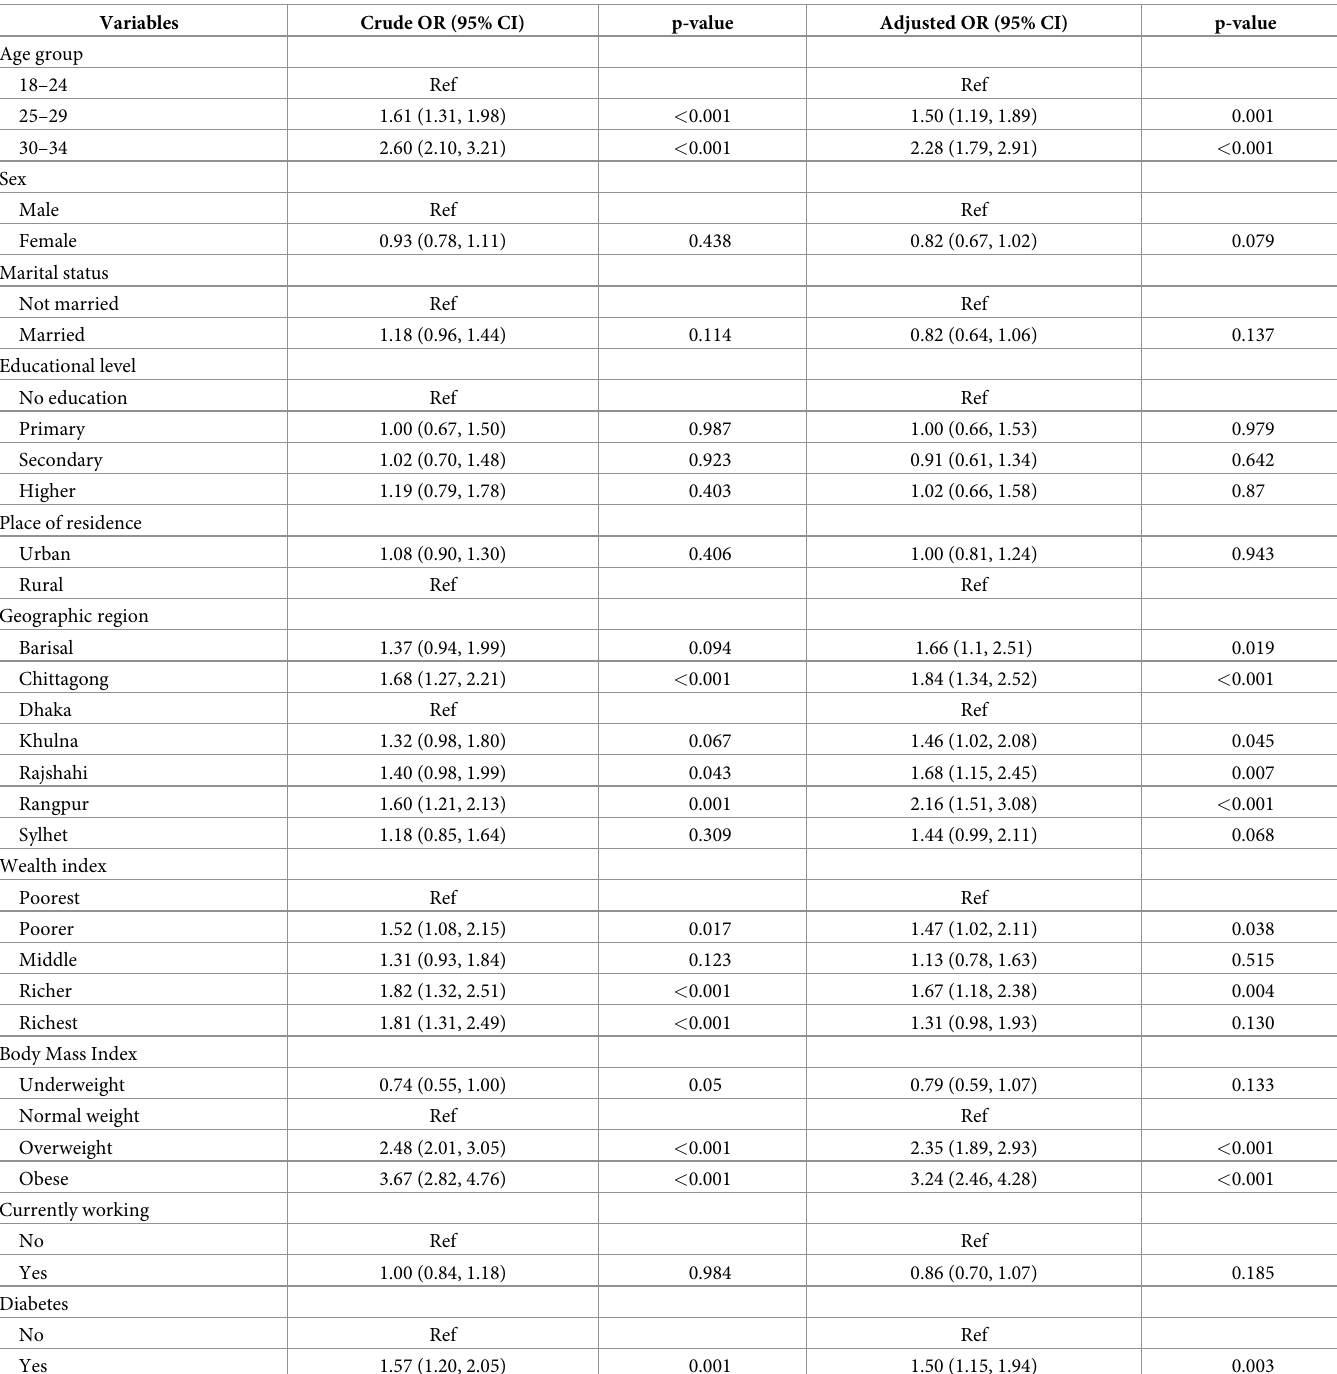
Table 3. Unadjusted and adjusted odds ratios of potential factors associated with hypertension among adults age 34 and younger in Bangladesh, BDHS 2018.